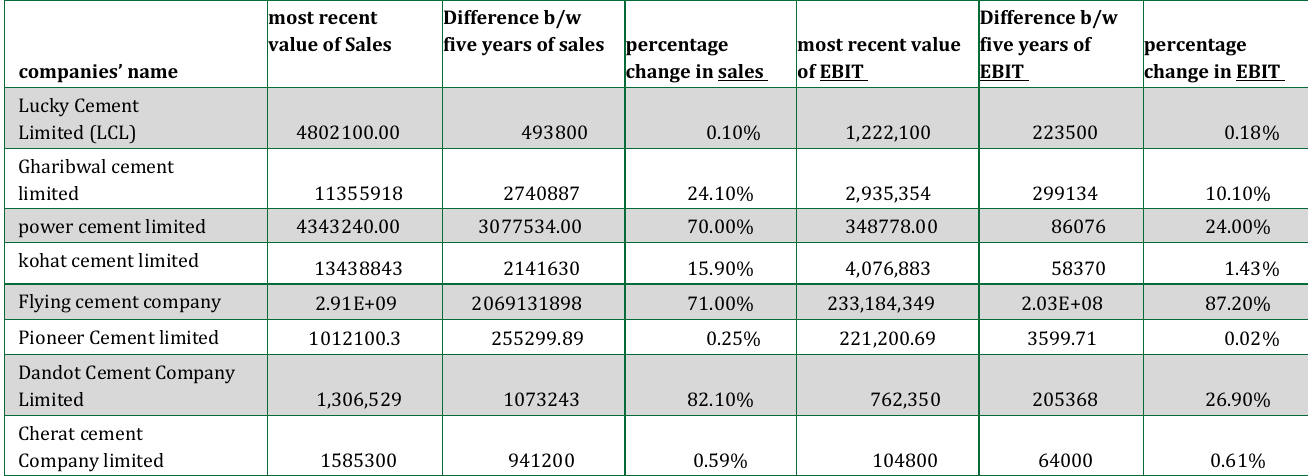
Table 1: Calculation of degree of operating